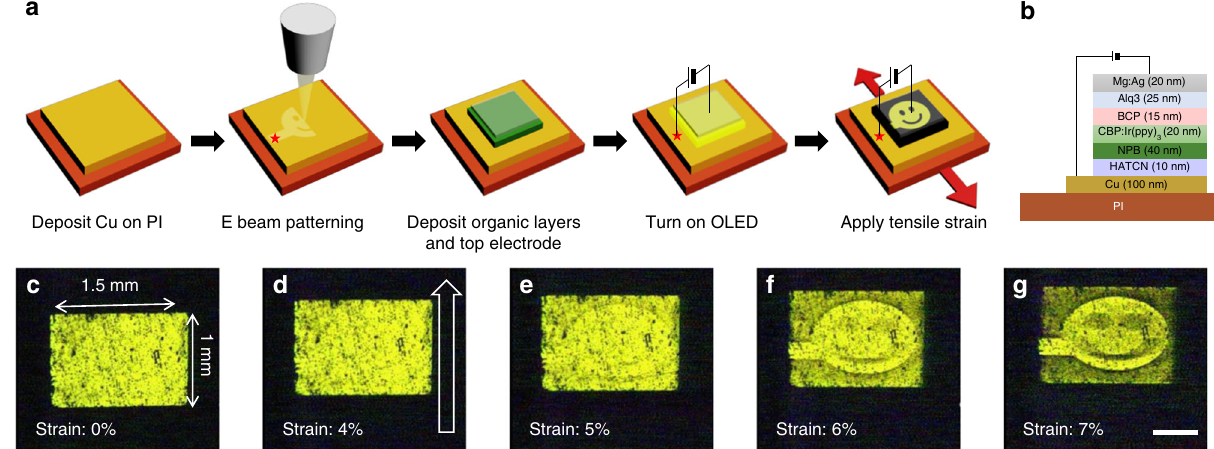
Fig. 4 Fabrication and behavior of a strain-responsive OLED patterned by e-beam irradiation. a Schematic illustration showing the fabrication and test procedures of the strain-responsive OLED. A red star-shaped dot marked on the Cu fi lm denotes the location of the positive bias. b Layer structure of the OLED. c – g Images of the OLED under a bias of 8 V at ε = ( c ) 0, ( d ) 4, ( e ) 5, ( f ) 6, and ( g ) 7%. Red and black arrows in a and d , respectively, denote the direction of the tensile strain. Scale bar, 500 μ Methods Sample preparation . To deposit an array of Cu thin fi lms (thickness: 100 nm, width and length: 100 μ m) on a 125- μ m-thick PI substrate (Kapton ® , DuPont), thermal evaporation using a metallic shadow mask (Supplementary Fig. 1) was employed. A spherically shaped Cu pellet (purity of 99.99%) was used as a deposition source. The base pressure and deposition rate were 2 ×10 − 6 Torr and 8Ås − 1 , respectively. Electron beam irradiation . Prior to e-beam irradiation and SEM observation, 10-nm-thick Pt fi lms were deposited to prevent charging of the non-conducting PI substrate. E-beam irradiation was performed using an SEM (Inspect F or Quanta 3D FEG, FEI). Detailed e-beam conditions are summarized in Supplementary